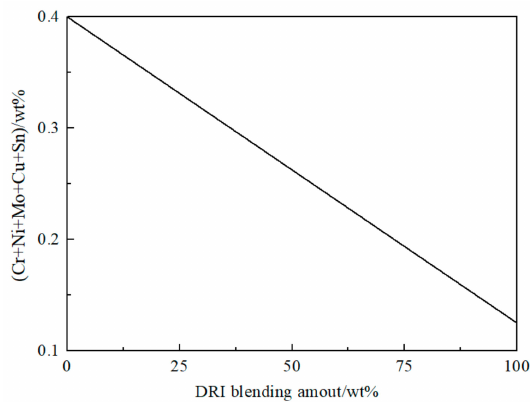
Figure 2. Relationship between direct reduced iron (DRI) blending amount and residual element content in liquid steel [50].